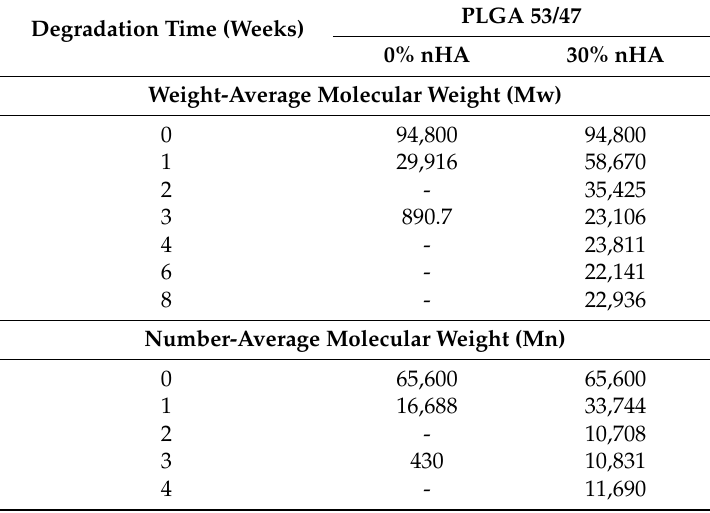
Table 1. Mw, Mn and I as a function of degradation time for PLGA (53/47) and PLGA (53/47)/nHA composite